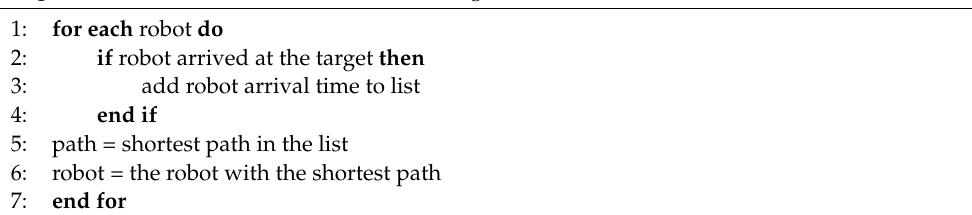
Figure 10. Obstacles in the work area. Algorithm 5 Solution: Obstacles in the working area